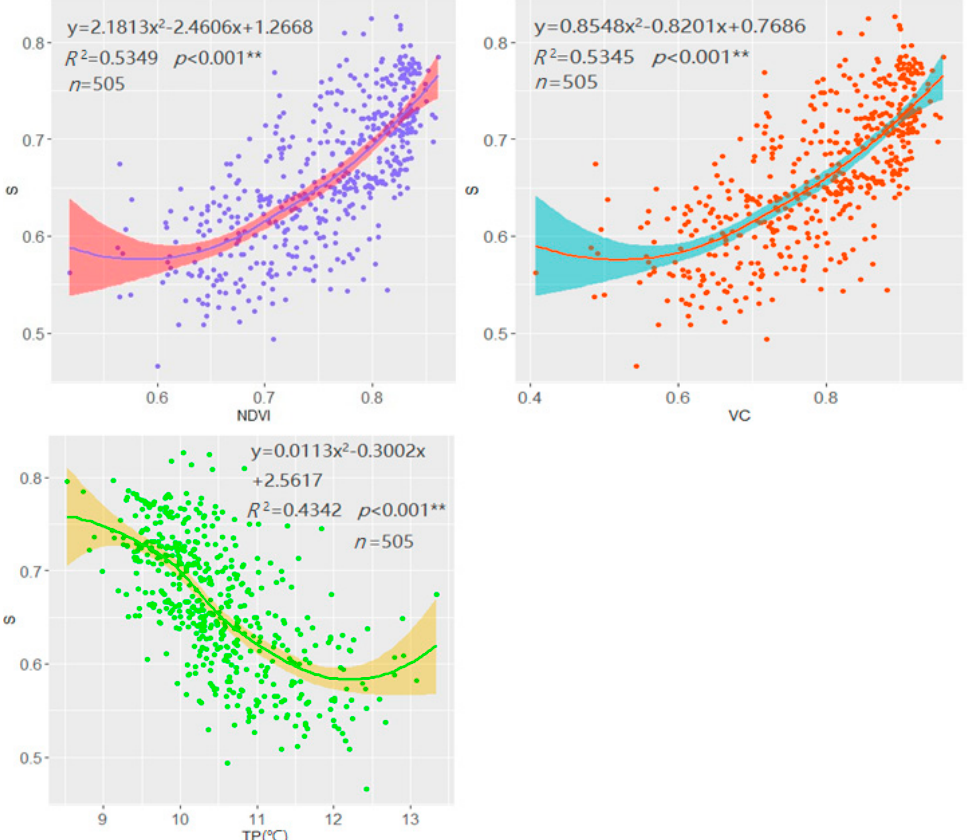
Figure 7. Relationship between NDVI, VC, TP, and S with 95% CI. ** represents a significant correlation at 0.01 level (bilateral). S represents ecological security index; LES represents land ecological security; NDVI represents normalized differential vegetation index; VC represents vegetation coverage; TP represents land surface temperature; CI represents confidence interval. Shaded areas represent 95% confidence intervals.